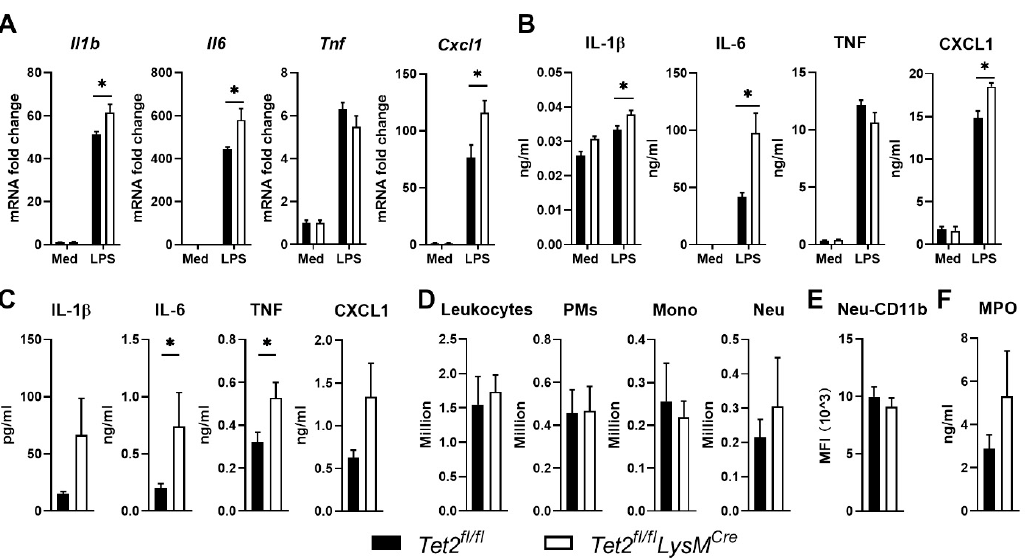
Figure 5. Myeloid Tet2 deficiency enhances IL-6 and TNF release during LPS induced peritonitis. ( A ) Ilb , Il6, Tnf and Cxcl1 expression in peritoneal macrophages (PMs) from Tet2 fl/fl LysM Cre (open bars) and control mice (black bars) after stimulation with medium control or LPS for 12 h; mRNA expression was normalized to Hprt mRNA; ( B ) IL-1 β , IL-6, TNF and CXCL1 production by PMs from Tet2 fl/fl LysM Cre and control mice after stimulation with medium control or LPS for 12 h; ( C ) IL-1 β , IL-6, TNF and CXCL1 protein levels, ( D ) number of total leukocytes, PMs, monocytes (Mono) and neutrophils (Neu), ( E ) neutrophil CD11b expression and ( F ) MPO levels in peritoneal lavage fluid of from Tet2 fl/fl LysM Cre and control mice 6 h after intraperitoneal administration of LPS (2 mg/kg). n = 6 for ( A , B ), n = 8 for ( C – F ). Data is shown as bar graphs with mean ± SEM. p values were calculated using Mann–Whitney test. * p <